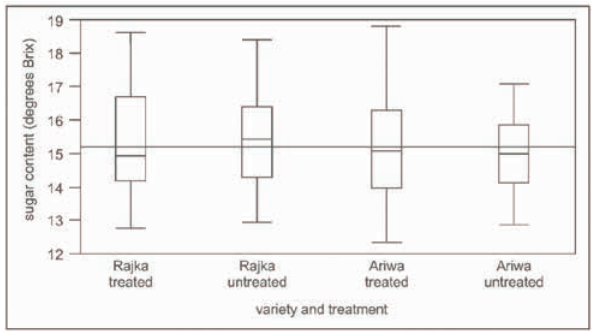
Figure 2: Sugar content of the apples per variety and treatment, mean and boxplots with median of n